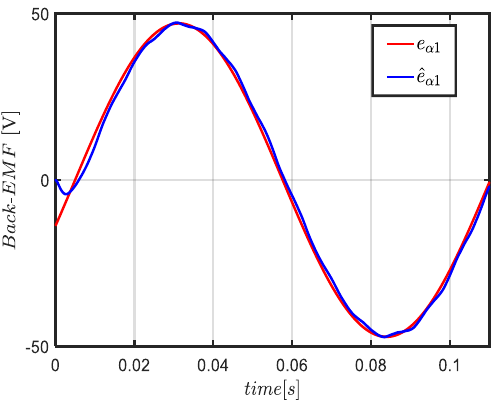
Figure 7. Simulated waveforms of the actual and estimated α -axis back EMF of the 1st harmonic in MM.